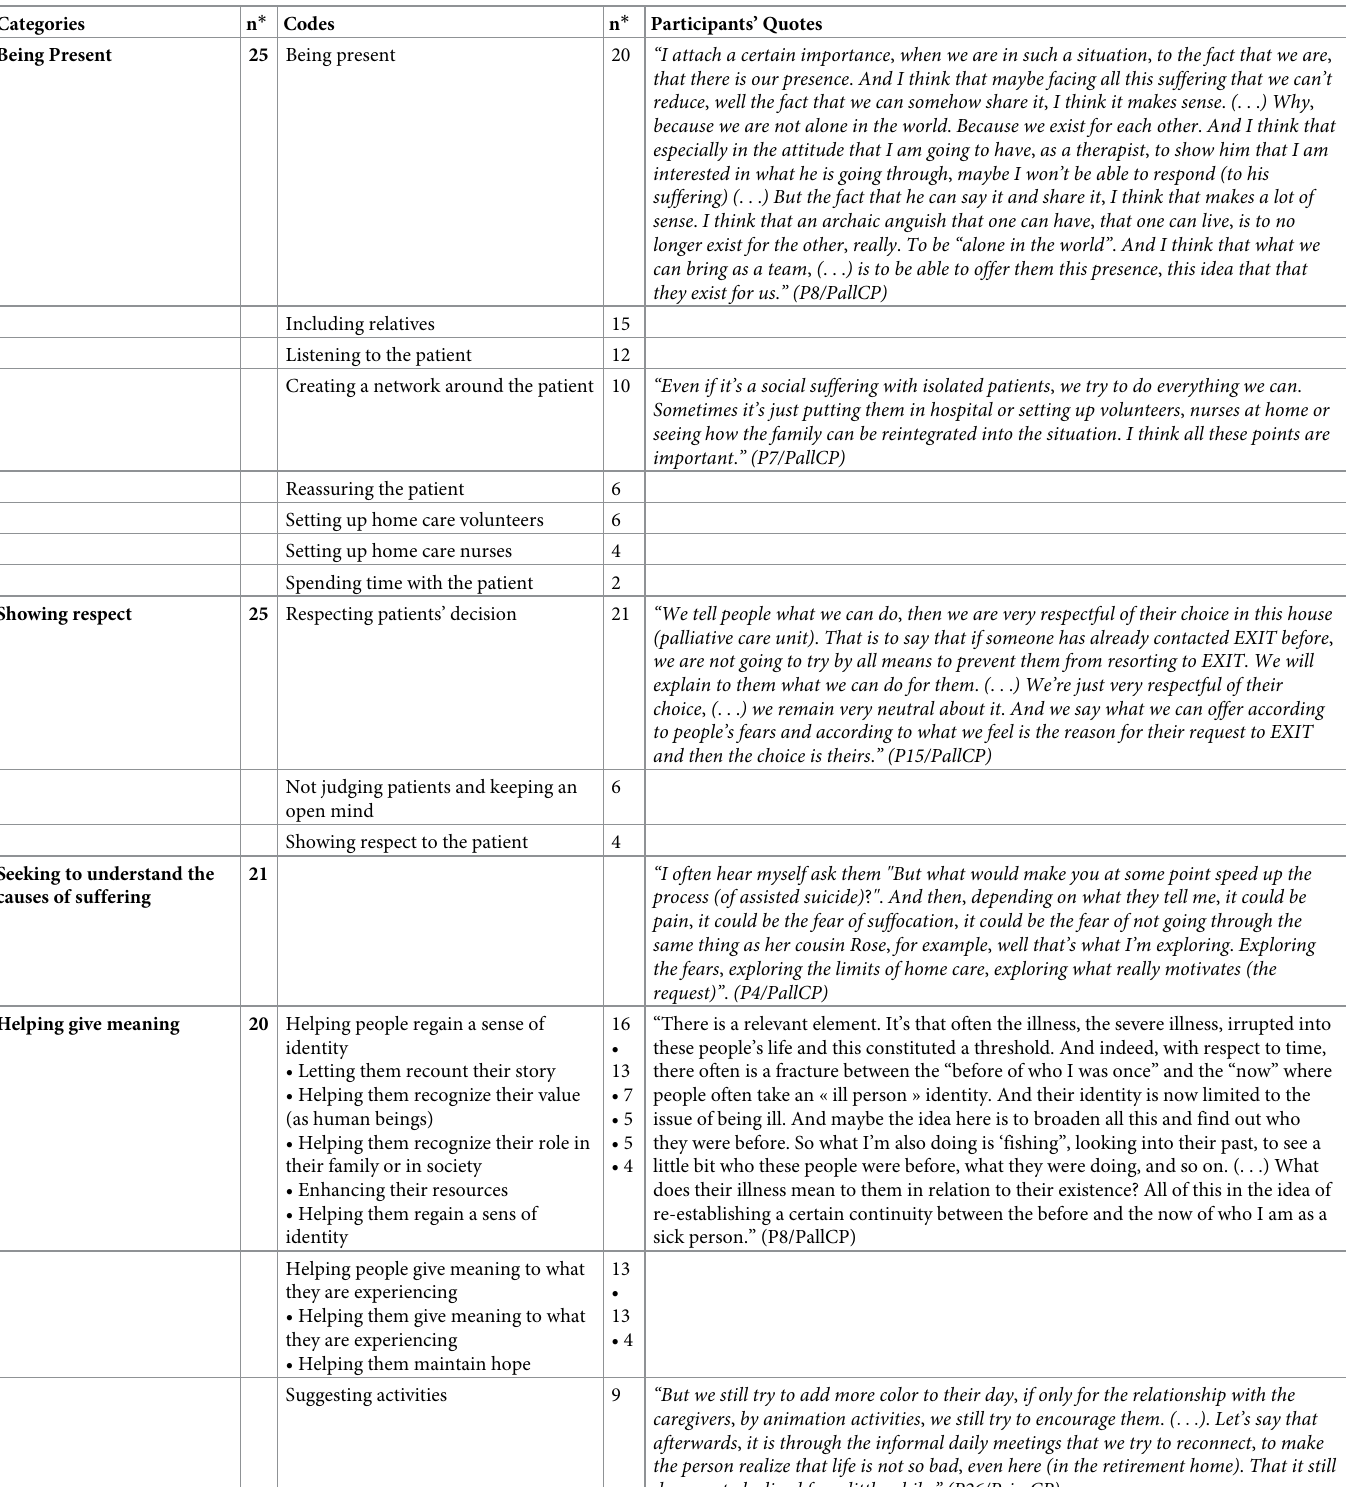
Table 3. Management of existential suffering in AS requests.